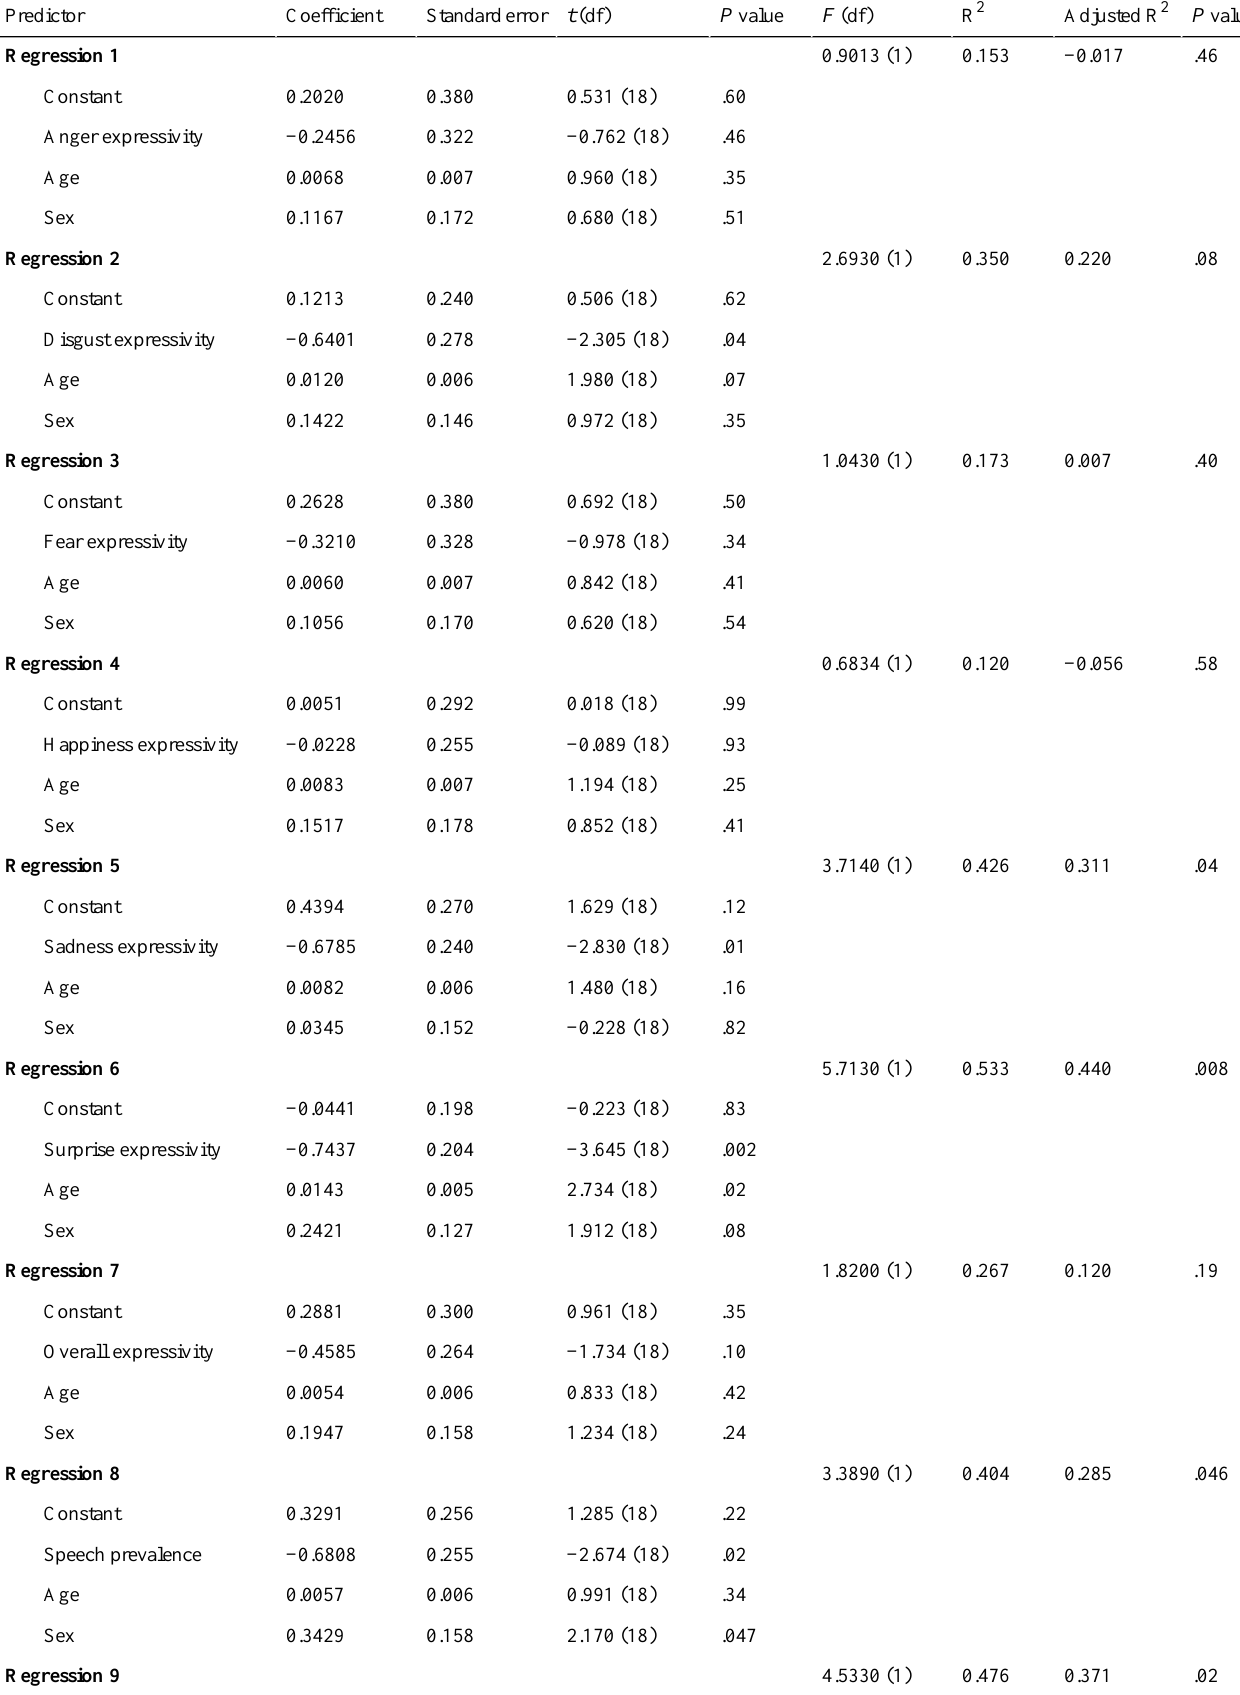
Table 1. Results from multiple linear regression between Beck Scale for Suicide Ideation questionnaire scores and digital measurements of facial expressivity, vocal behavior, and head movement, controlling for age and